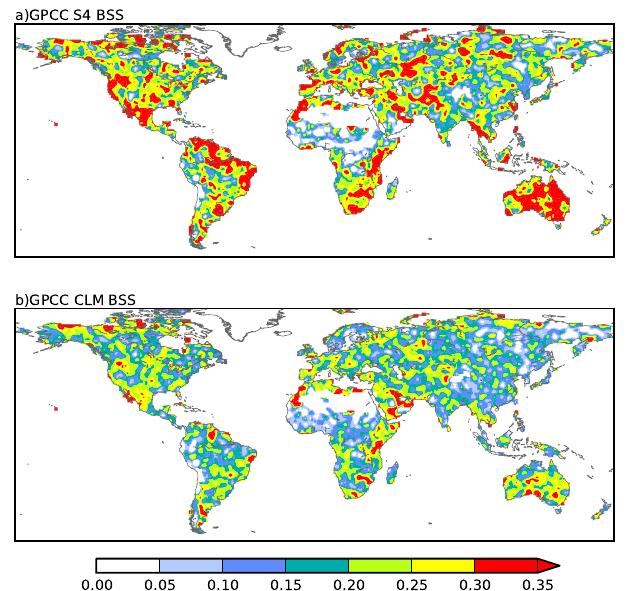
Figure 5. Brier skill scores for the drought onset forecasts of (a) GPCC S4 and (b) GPCC CLM. The reference forecast for the skill score was the climatological frequency of the verification data set. The original maps at 1 ◦ × 1 ◦ were smoothed with a 3 × 3 win-